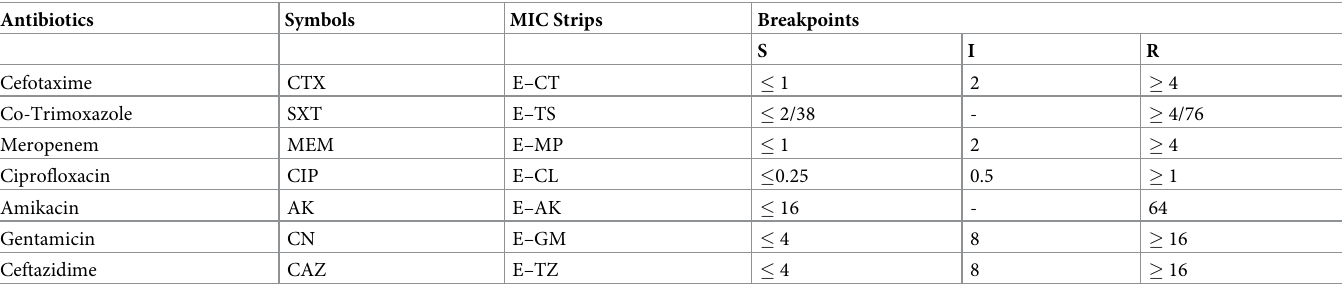
Key: S = Sensitive, I = Intermediate, R =